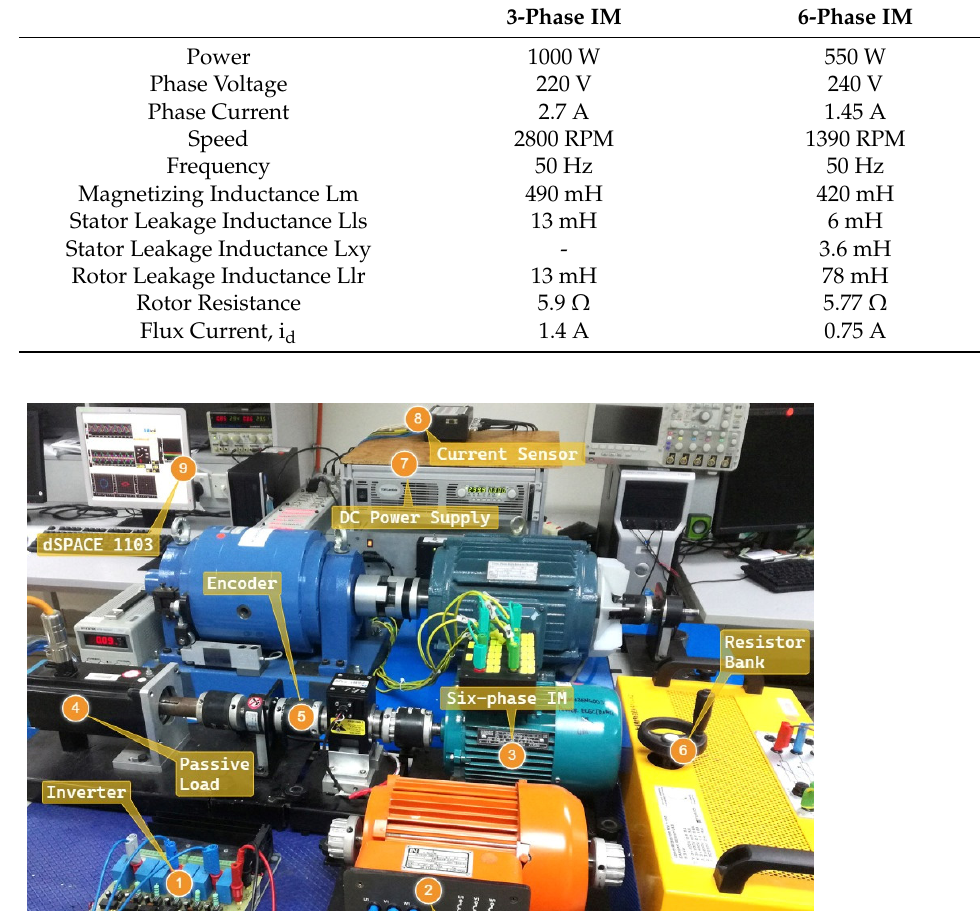
Table 1. kW three-phase and 0.55 kW symmetrical six-phase induction motors.